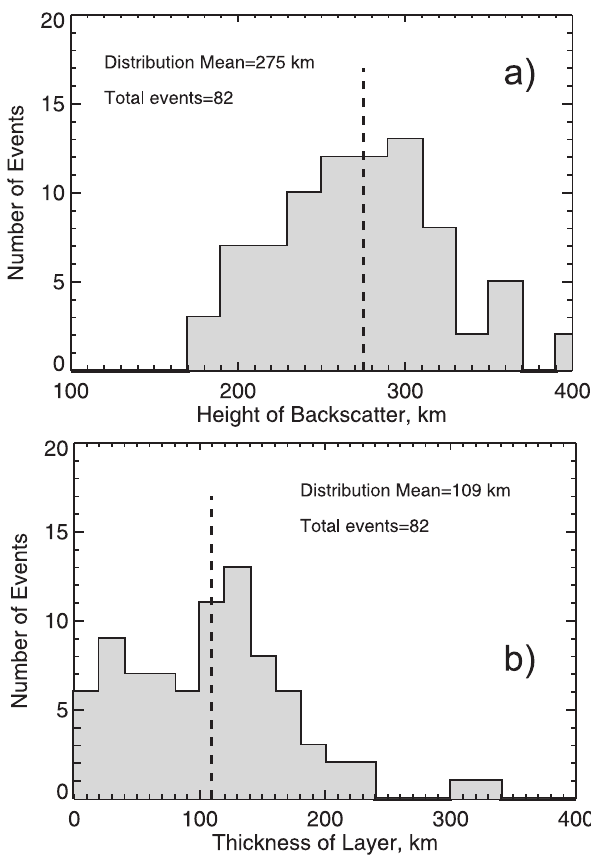
Fig. 5. Histogram distributions for (a) the heights of 1 / 2 hop prop- agation F-region echoes and (b) the altitudinal spread of expected echo heights (thickness of backscatter layer) for the entire data set of 82 events.